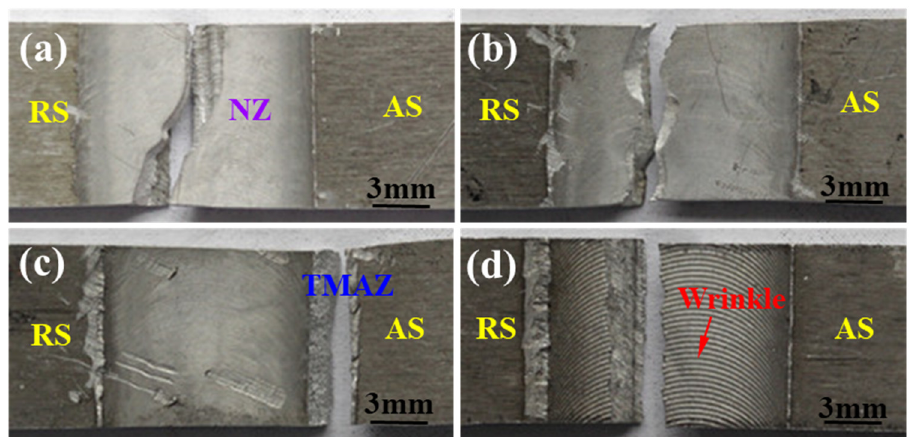
Figure 8. Fractured locations of tensile test joints: ( a ) 90 mm/min; ( b ) 120 mm/min; ( c ) 150 mm/min; ( d ) 180 mm/min.